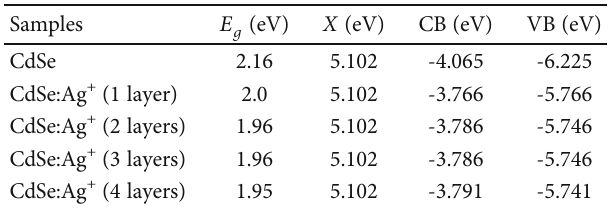
/CdSe:Ag + with thickness from 1 layer to 4 layers. 2 Table 1: The parameters of CdSe:Ag + fi lms are determined using Tauc plots and UV-Vis